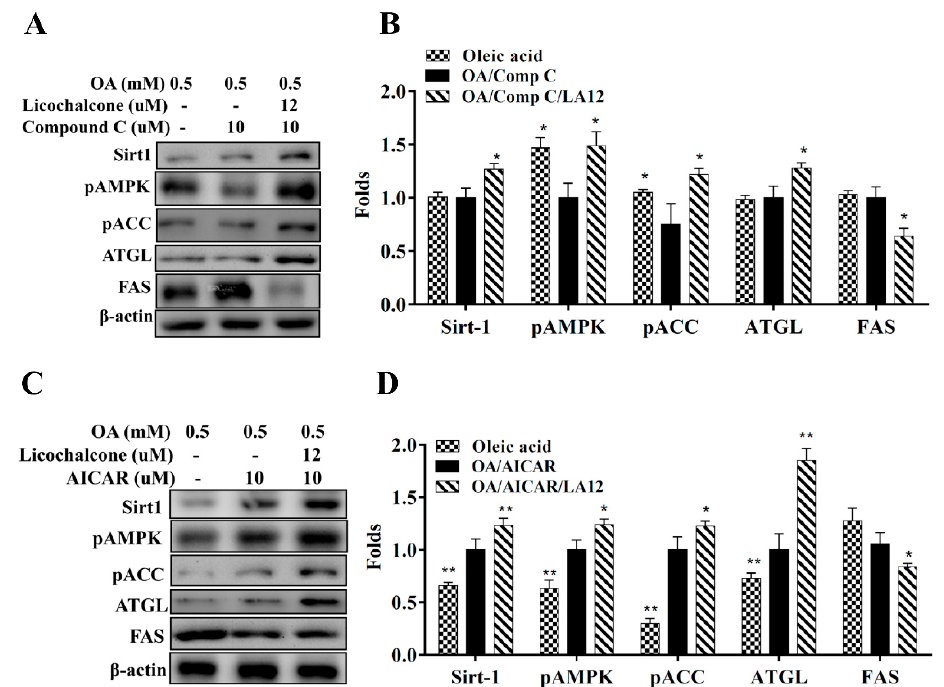
Figure 10. E ff ects of licochalcone A (LA) on AMPK / Sirt-1 pathway in HepG2 cells. HepG2 cells were treated with 0.5 mM oleic acid (OA) for 48 h, followed by licochalcone A (12 µ M) with or without ( A , B ) an AMPK inhibitor (compound C) or ( C , D ) an AMPK activator (AICAR) for 24 h. Three independent experiments were analyzed using β -actin as an internal control. The images were quantified and data are presented as the mean ± SEM; * p < 0.05, ** p < 0.01 compared with oleic acid-induced HepG2 cells.